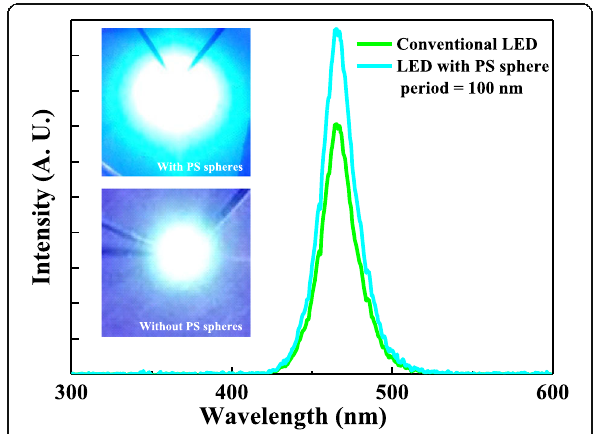
Fig. 6 Electroluminescence spectra as functions of wavelength for the conventional InGaN/GaN LEDs and InGaN/GaN LEDs with optimal periodic PS NS array window